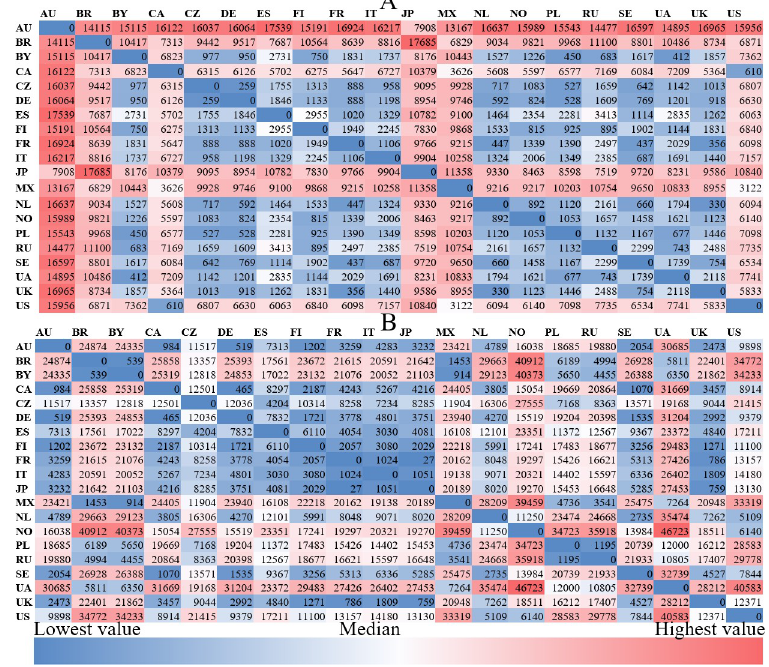
Fig 6. The between-country geographical and economic distances. (a): geographical distances in kilometers; (B): economic distances in current international dollars.